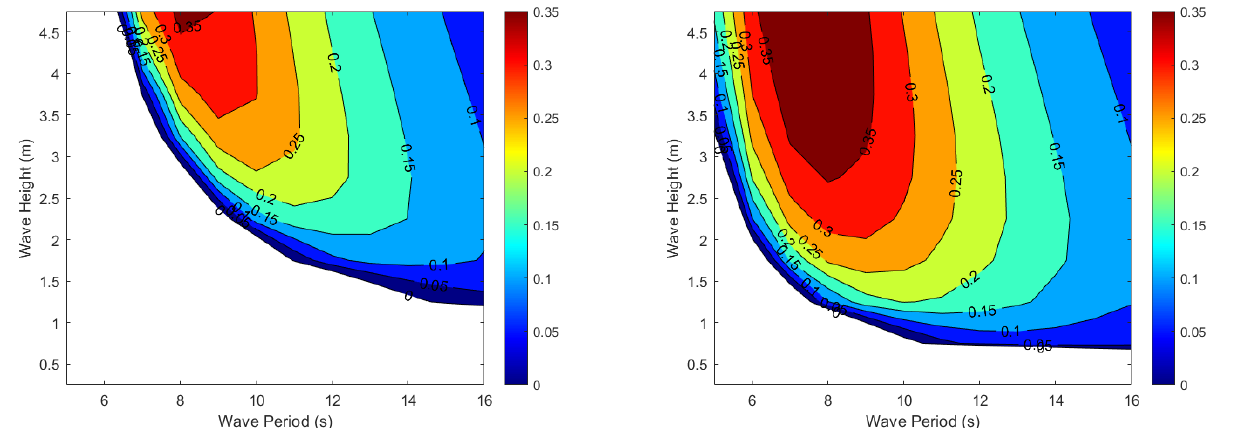
Fig. 10: Efficiency of power generation after harmonic and drag losses were considered for regular wave simulations. Left, controller 1. Right, controller 2.